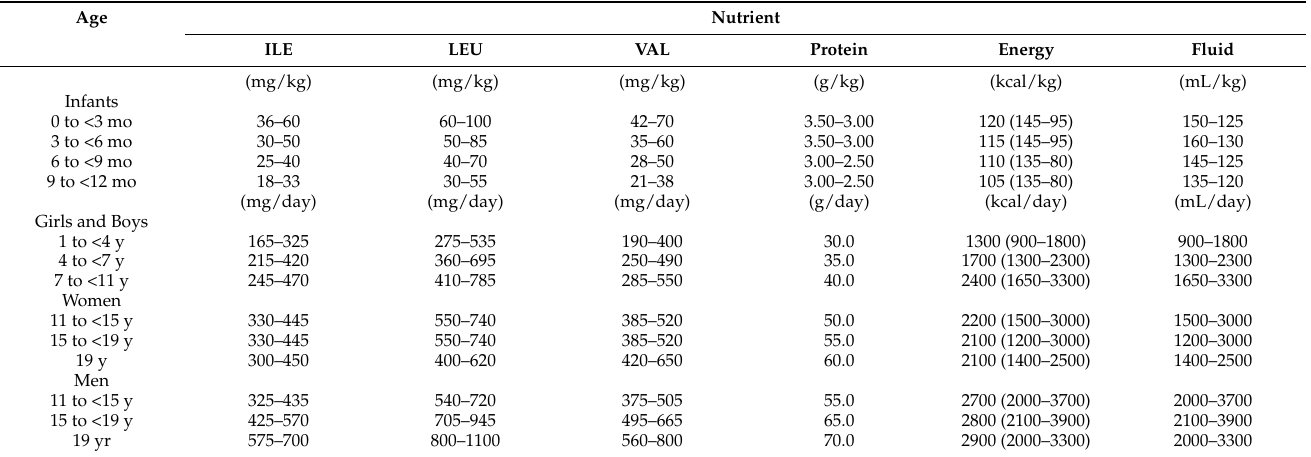
Table 3. Ranges of Adequate Intake for Infants, Children, and Adults With MSUD